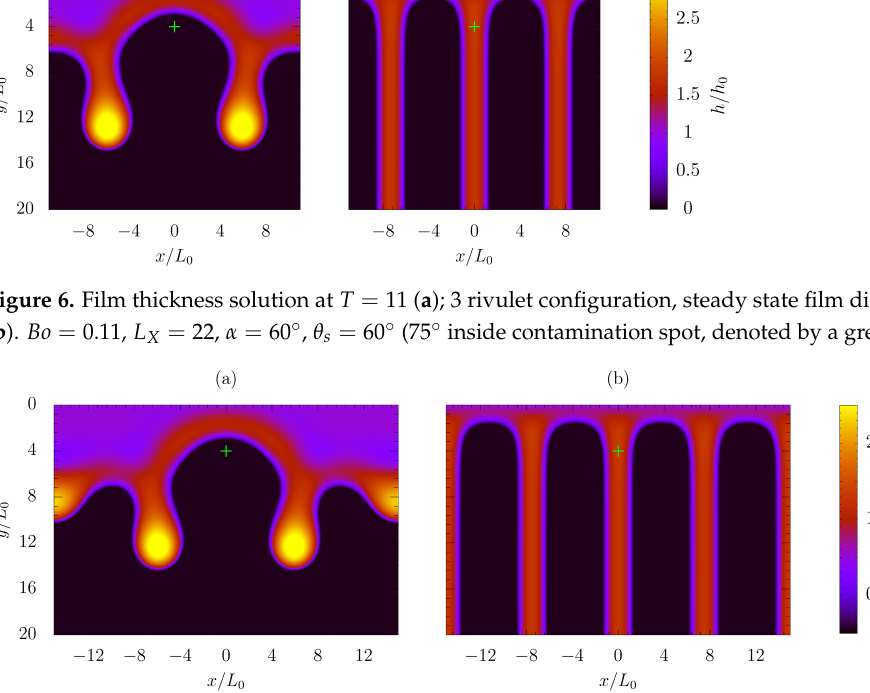
Figure 7. Film thickness solution at T = 11 ( a ); 4 rivulet configuration, steady state film distribution ( b ). Bo = 0.11, L X = 30, α = 60 ◦ , θ s = 60 ◦ (75 ◦ inside contamination spot, denoted by a green